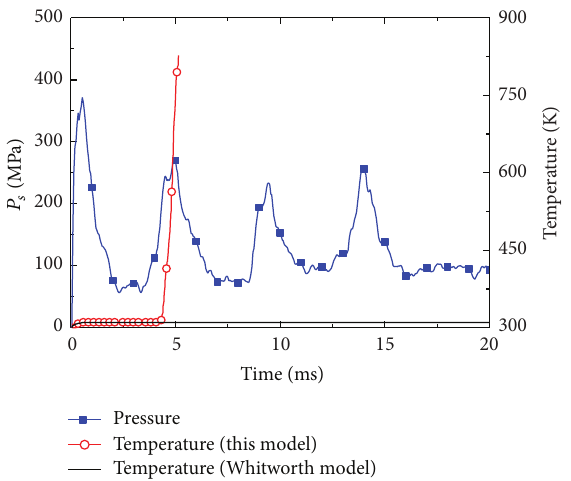
Figure 13: The pressure histories of the head charge in the simula- tion and temperature histories calculated with the two models. The “hot-spots” are generated during penetration in the second layer of the target with this model while the temperature remains 310K with the original